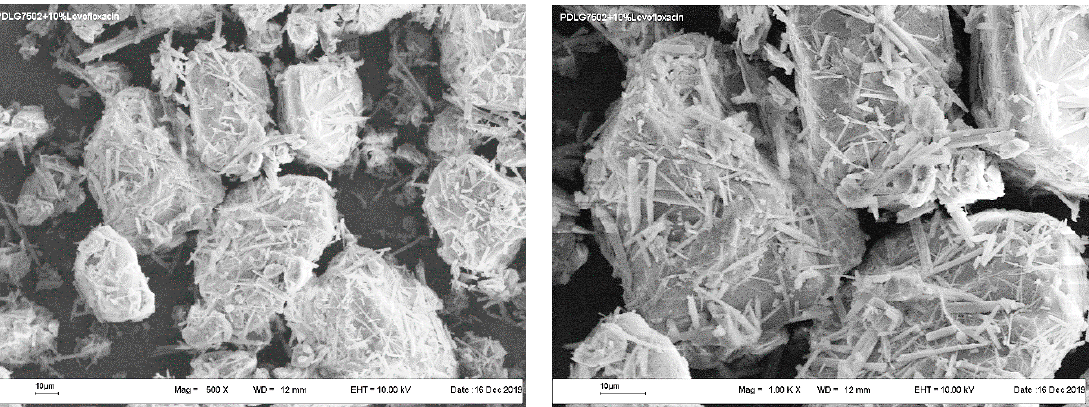
Figure 2. SEM images of a PLGA/LFX fine powder mixture at two different magnifications.